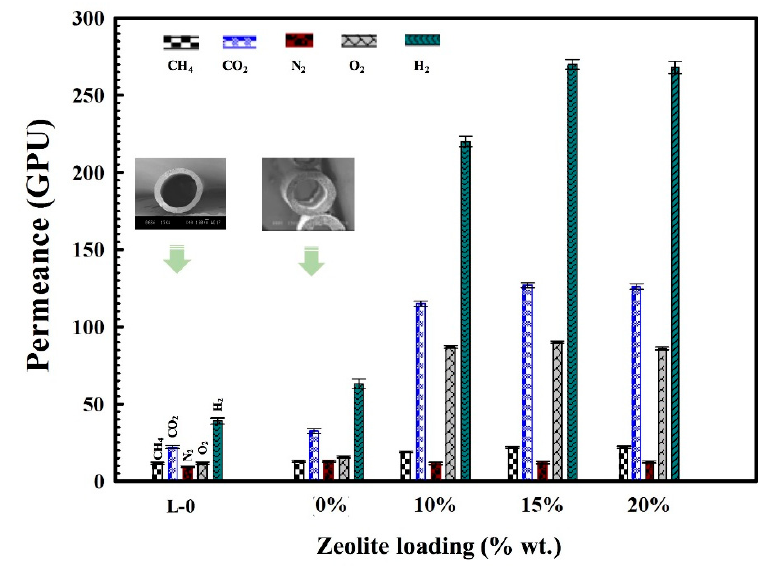
Figure 12. Permeance of various gases (CH 4 , CO 2 , N 2 , O 2 , and H 2 ) at 30 ◦ C and 30 psia for foamed and unfoamed hollow fiber MMFMs produced with different zeolite loading (0, 10, 15, and 20 wt %) at a stretching speed of 5 m/min.